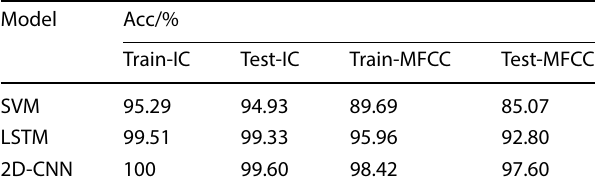
Table 2 Comparison of the Accuracy of each model in datasets